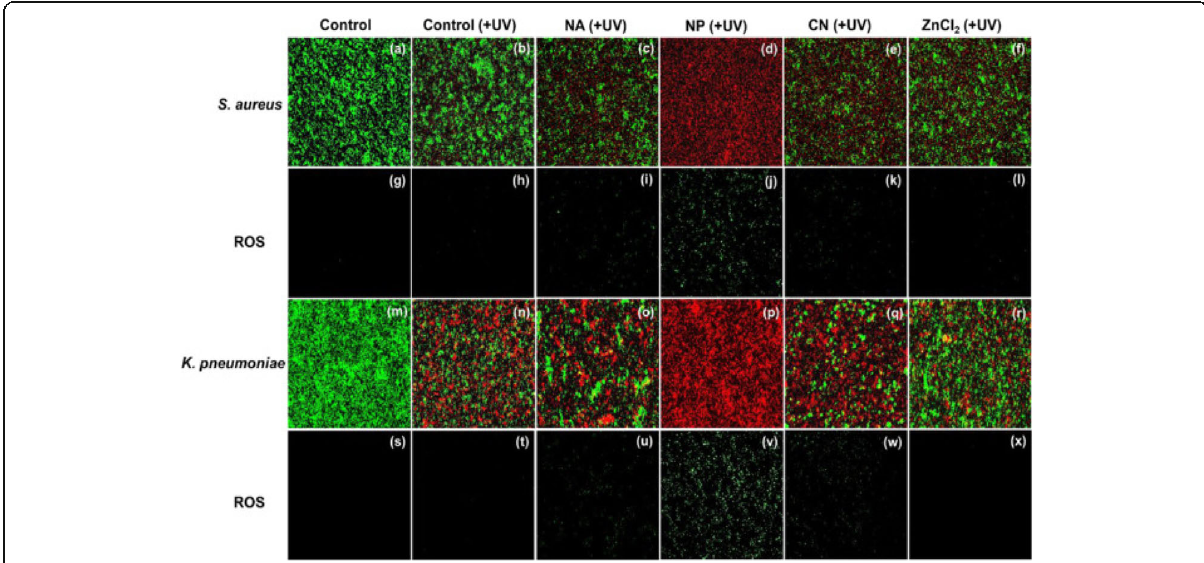
Fig. 4 Dual immunofluorescence and ROS staining images for S. aureus ( a – j ) and K. pneumoniae ( k – t ) treated with nanoassemblies, NPs, conventional NPs, and ZnCl 2 (0.35 mM) under dark conditions. Reproduced from ref. [16] with permission from